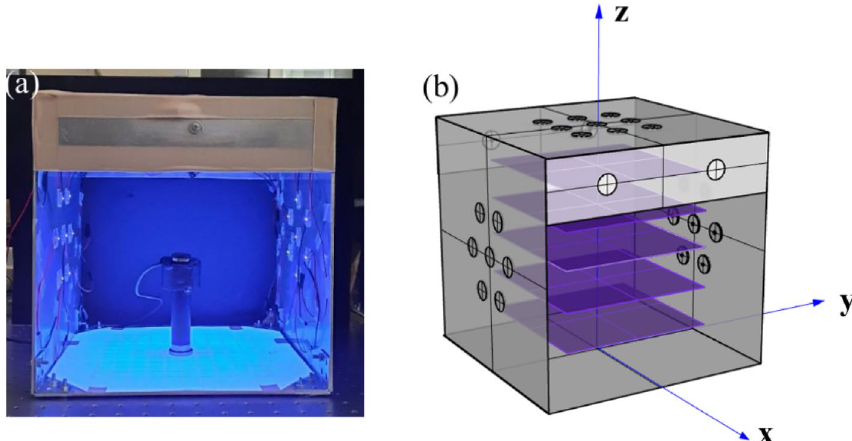
Figure 4. ( a ) The photo of the irradiance measurement, and ( b ) description of several measured sections.